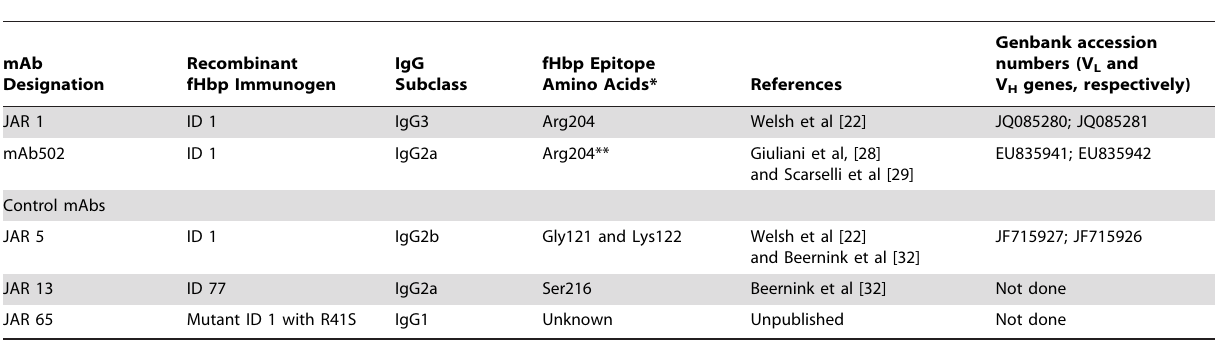
Table 2. Properties of the murine anti-fHbp